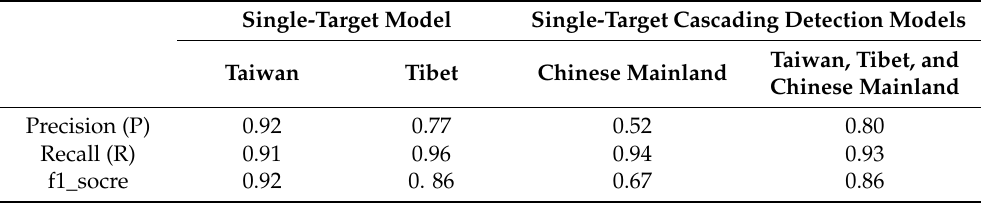
Figure 4. Training loss of single-target and multi-target detection models: ( a ) Training loss of model for target 1 (Taiwan); ( b ) Training loss of model for target 2 (Tibet); ( c ) Training loss of model for target 3 (Chinese mainland); ( d ) Training loss of model for all three targets. Table 3. Accuracy statistics of different targets with the single-target cascading detection model.